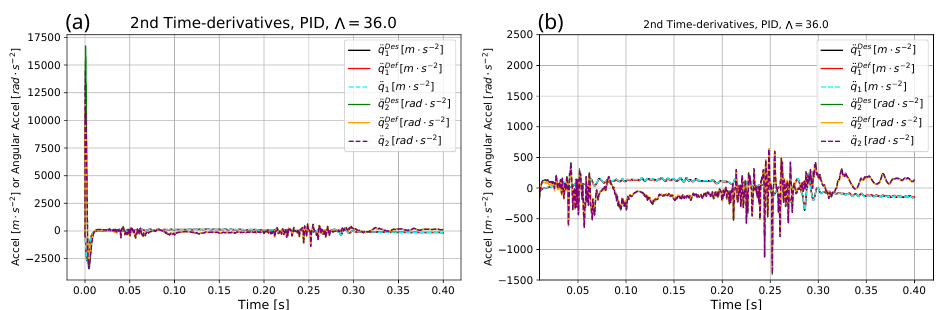
Figure 17. Trajectory tracking errors without force limitation for the increased α min = 0.1. ( a ) For nominal-optimized: q N − q O . ( b ) For optimized-realized: q O − q .